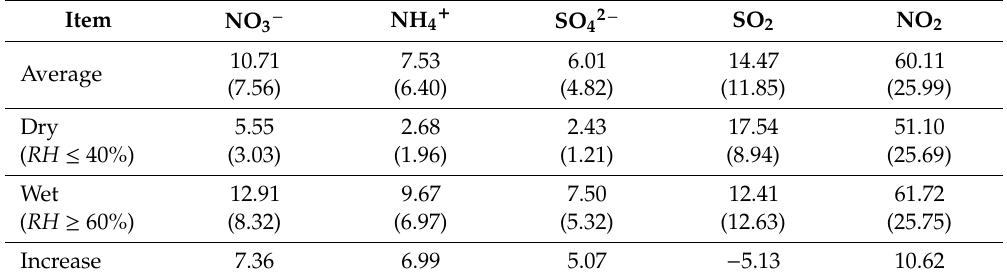
Table 3. Variation statistics of secondary inorganic salts and gaseous precursors during winter ( μ g/m 3 ).